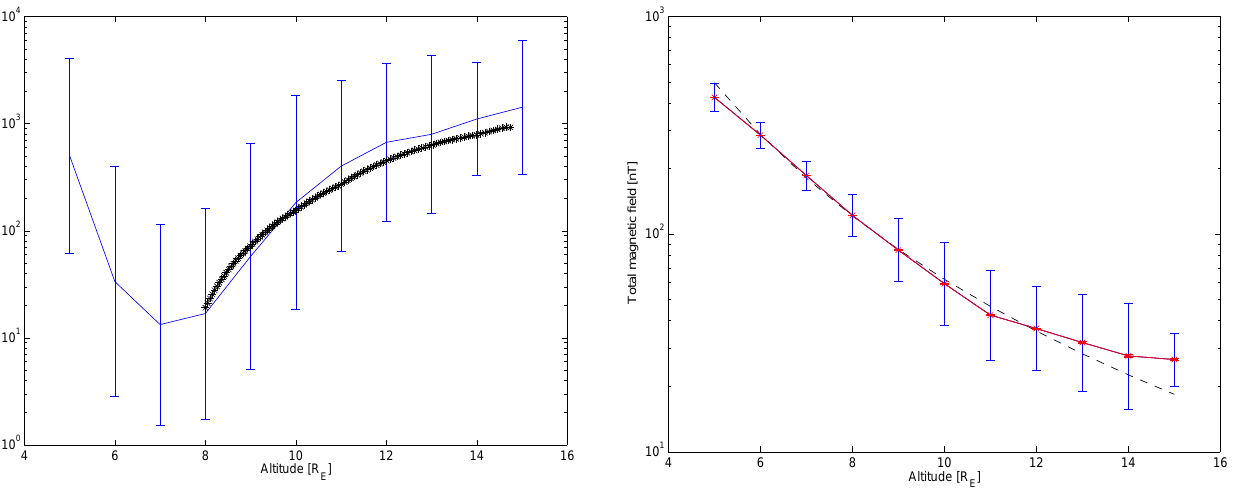
Fig. 7. Profile of the total magnetic field versus altitude. The blue error bars show the standard deviation for the logarithmic values. The black dashed line is the dipole model.